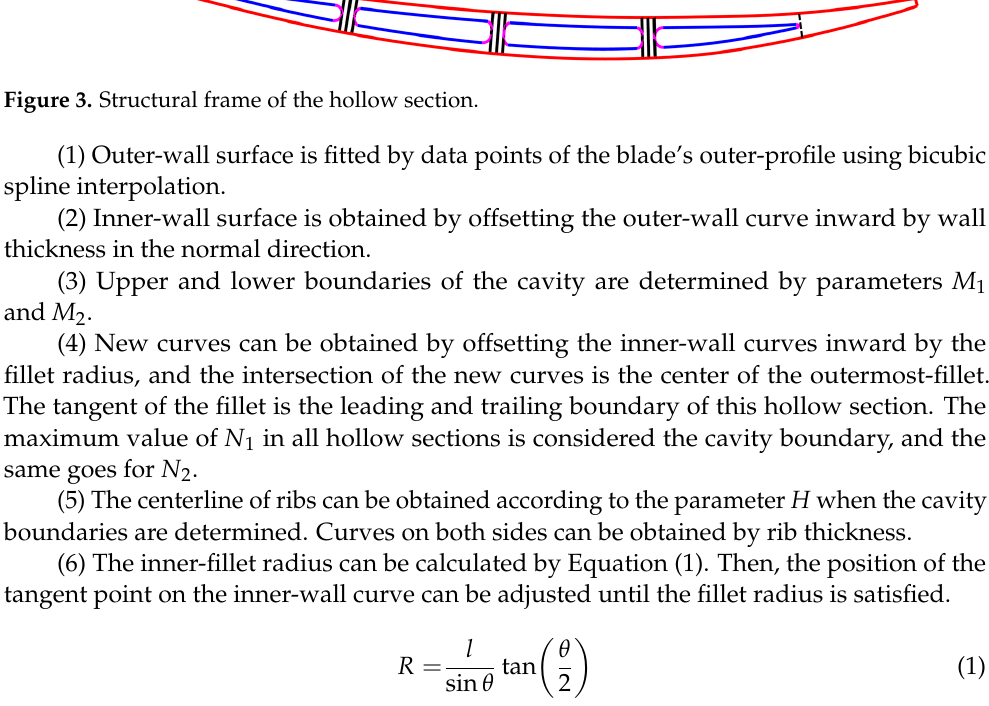
meshes of adjacent